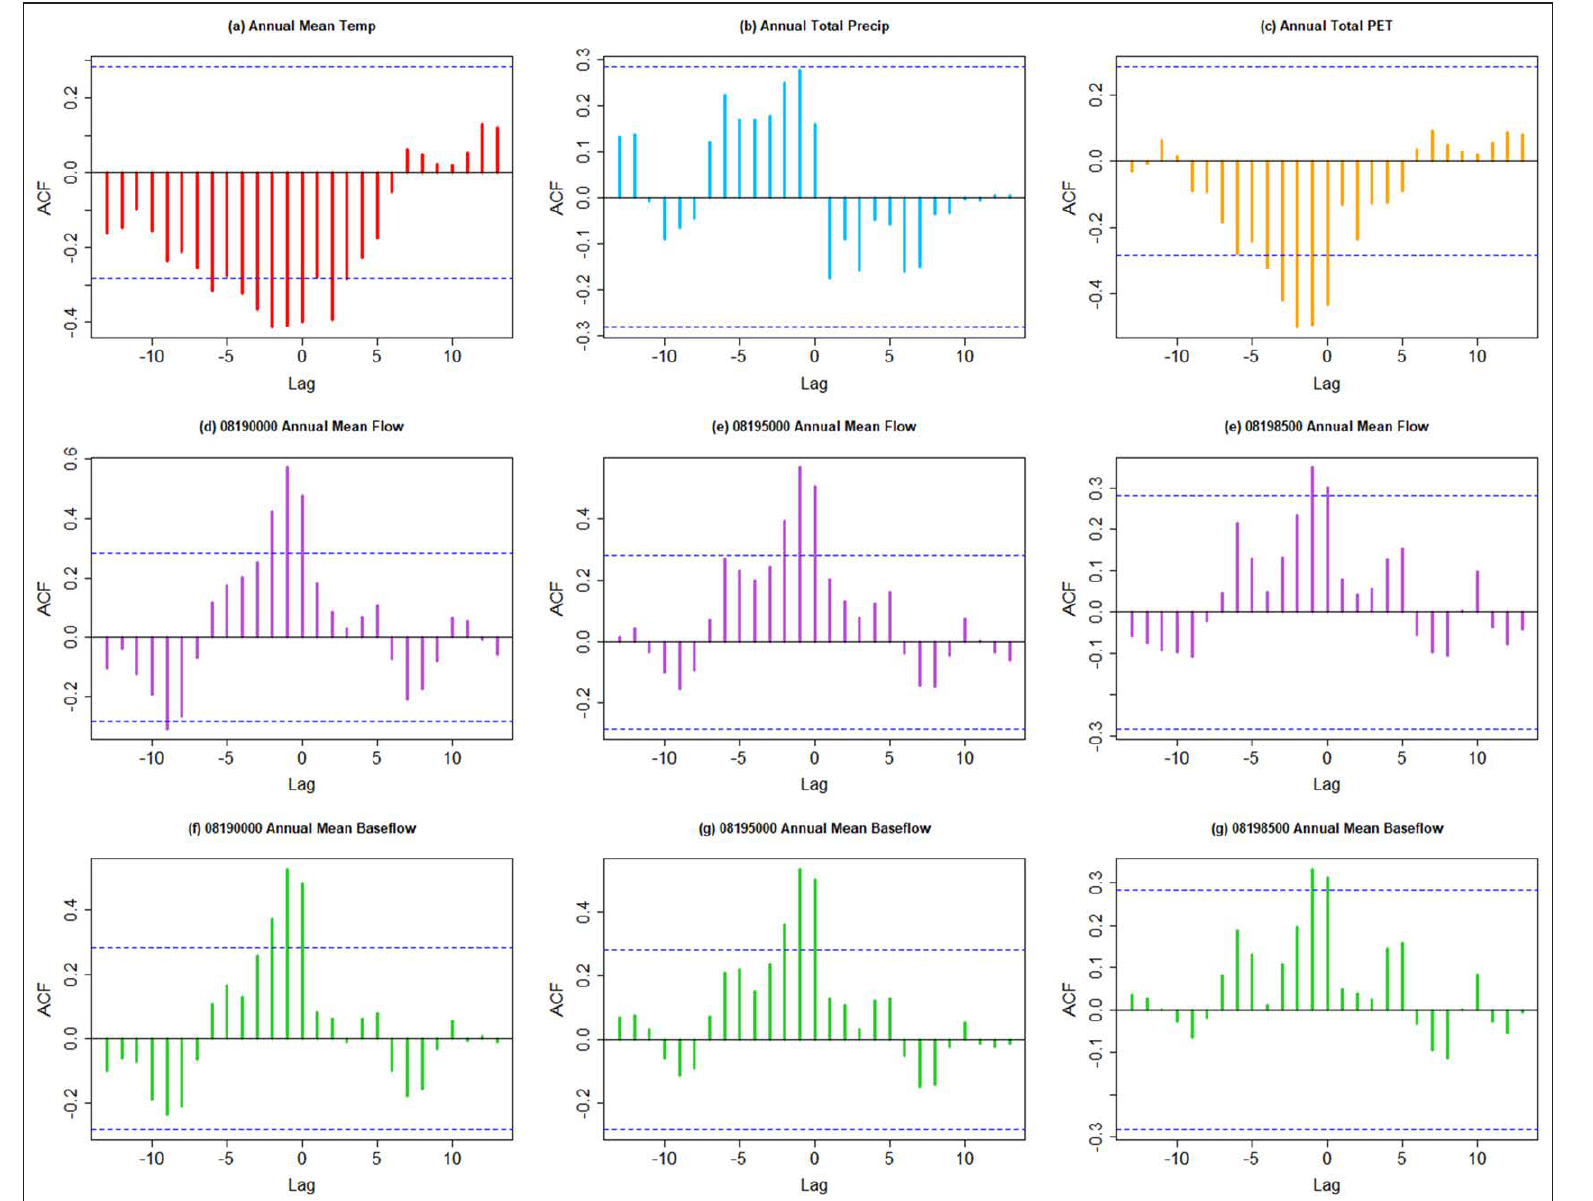
Figure 7. Cross-correlations between the annual mean of daily-high water levels at well J27 and (a) – (c): CRU variables in the EPE grid, (d) – (e): annual mean flows and (f) – (g): annual mean baseflows in upgradient